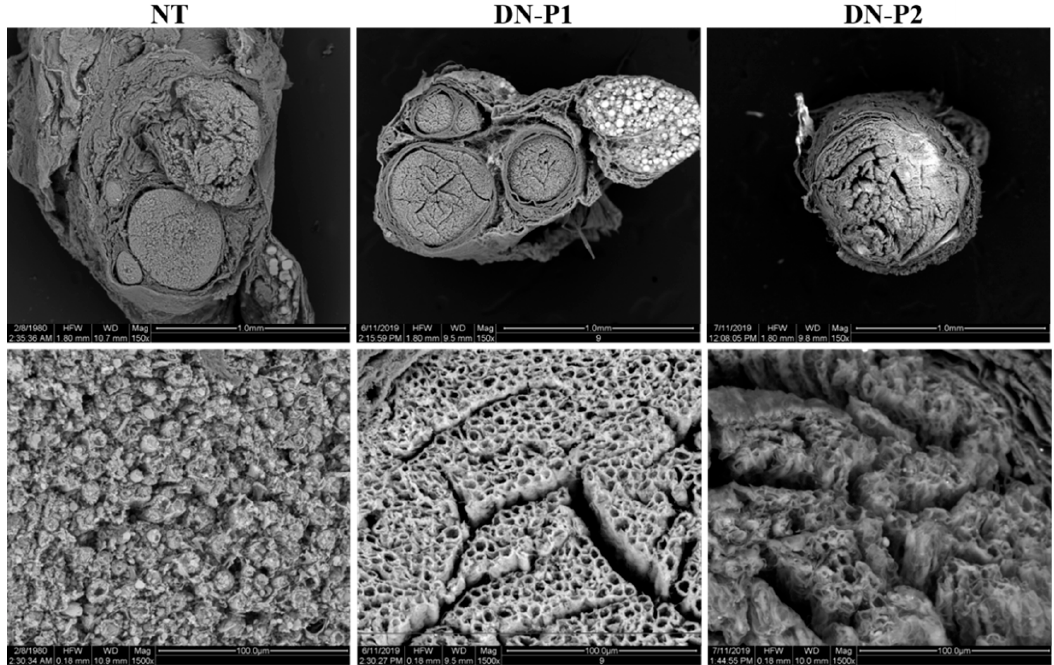
Figure 5. Scanning electron microscopy (SEM) representative panel. SEM detects the surface ultrastructure and the changes occurred in rat sciatic nerves following the decellularization process.